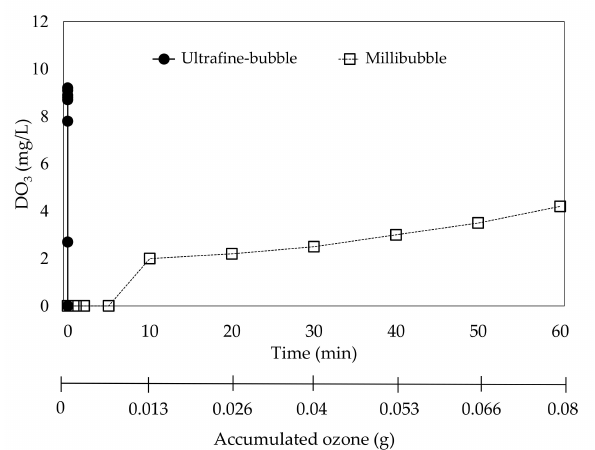
Figure 2. Concentration of dissolved ozone during ultrafine-bubble ozonation with deionized (DI) water (flow rate 40 mL/min; temperature 25 ◦ C; pH